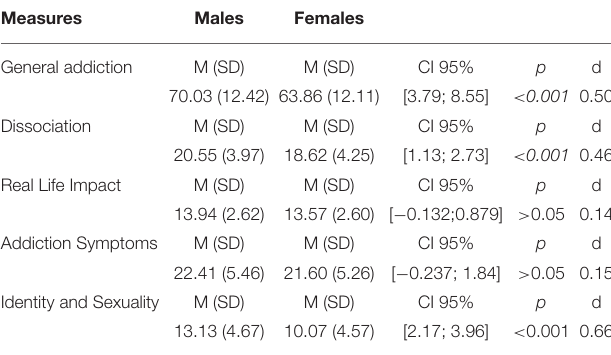
TABLE 2 | General and detailed Internet addiction with respect to gender of